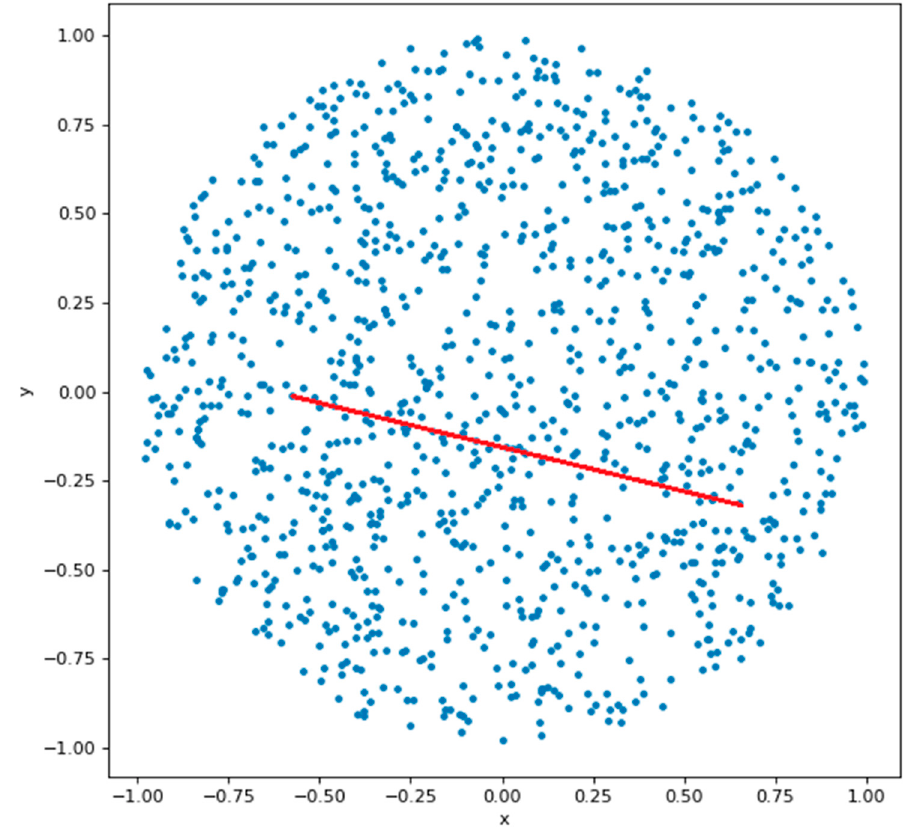
Figure 1. Distance between two randomly chosen points in a set of points independently and uniformly distributed in a disk (as generated by a homogeneous Poisson process). Among all possible distances between points, how likely would this distance be? Would it be below or above average?